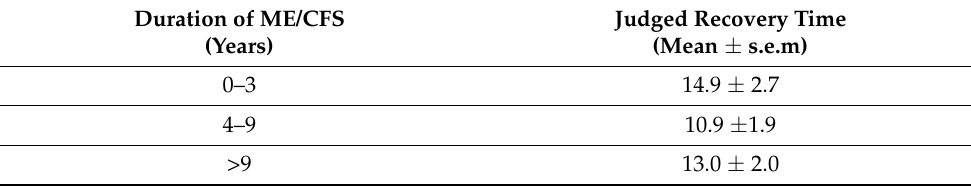
Figure 2. Mean score of all nine domains of the SSS instrument—ME/CFS subjects only. The shaded area represents the 95% confidence interval. Note that there are a significant number of data points beyond day 10, representing about 7–8% of ME/CFS subjects. Each dot is the mean SSS score for an individual ME/CFS subject; Blue line is the spline curve representing the average of all data points in the figure; Light blue area is the 95% confidence interval. Figure 3 contrasts the spline curves and confidence intervals for ME vs. CTL groups in PEM by Survey Day. ANOVA reveals significant differences between groups (F = Table 2. Recovery Time by Duration of 2555.8, p < 0.0001) and by survey day (F = 5.37, p < 0.05).